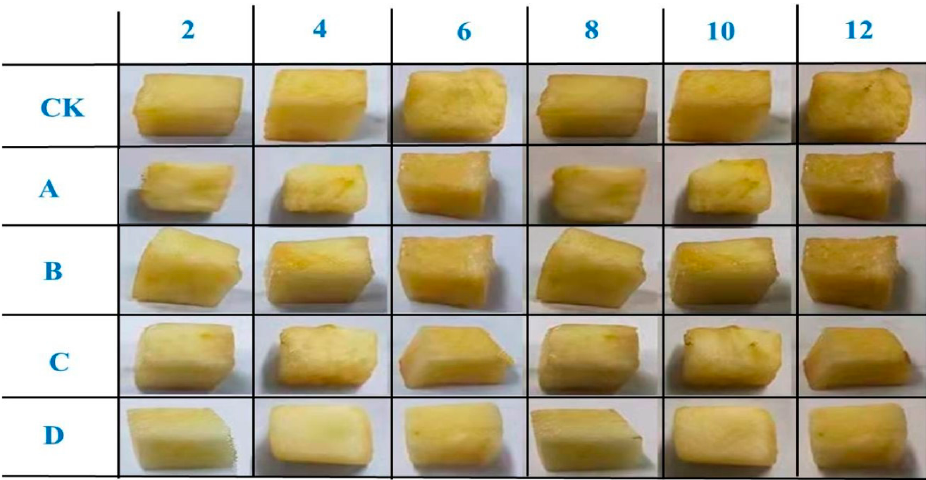
Figure 7. The shape and color changes of fresh-cut apples during 12 storage days (A: pure SA mem- brane; B:SA/CW composite membrane; C: SA/CW/G composite membrane; D: SA/CW/G/Vc-Ca composite membrane).